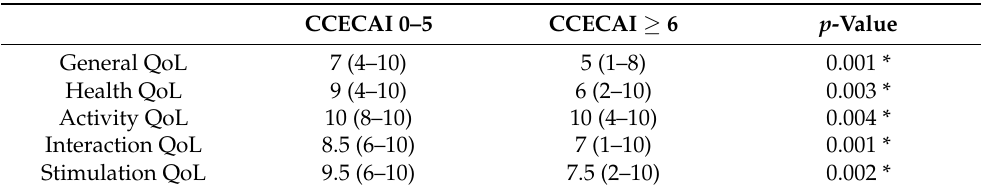
Table 2. Results of QoL scores on the first visit in the enteropathic group based on CCECAI groups (0–5 and ≥ 6) (* = p <